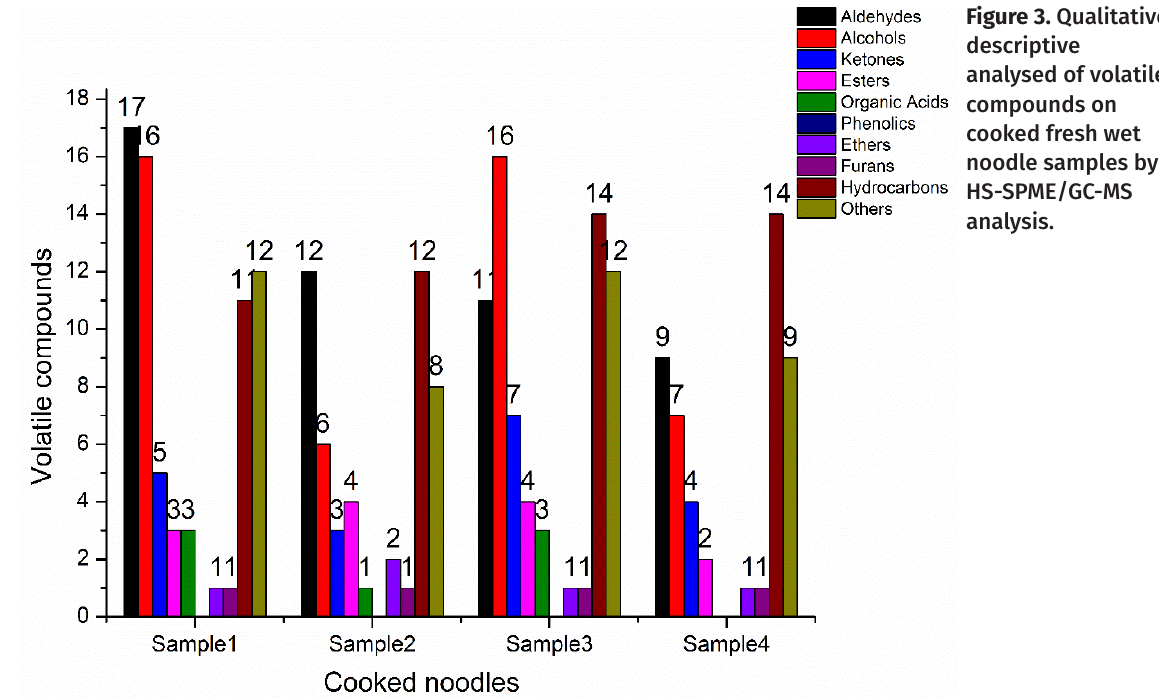
Figure 3. Qualitative descriptive analysed of volatile compounds on cooked fresh wet noodle samples by HS-SPME/GC-MS